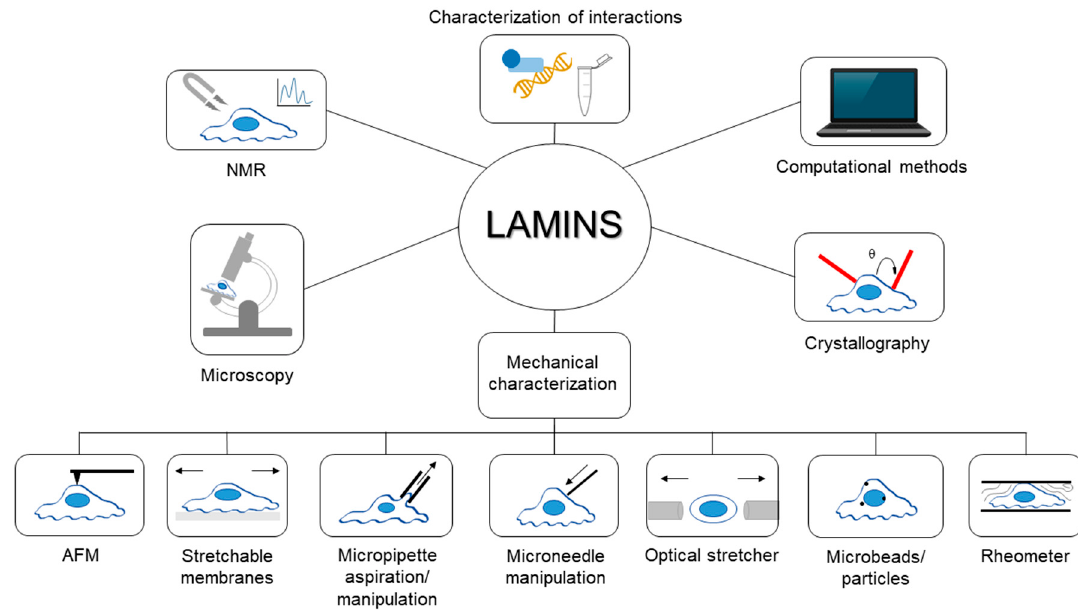
Figure 1. General overview of the techniques described in the review. In the figure, samples have been identified as cells, even if some techniques, like rheological ones, are performed also with lamin solutions or different specimens.